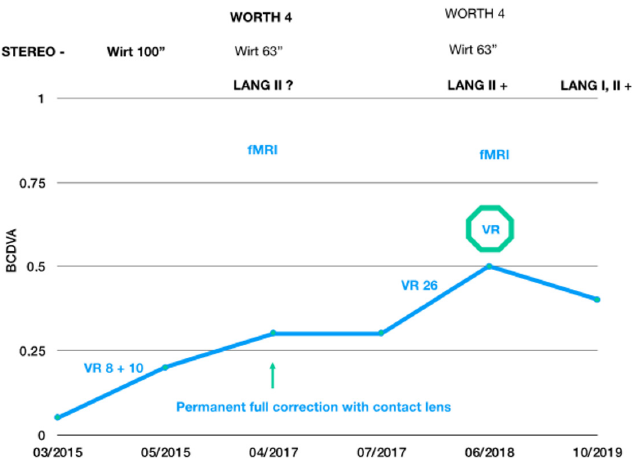
Figure 2. Summary of the visual training scheme. Time points are recorded on the x -axis, gains in BCDVA are recorded on the y -axis, and changes in stereopsis are recorded on top of the scheme. VR signs with different numbers denote how much time the patient spent in visual training in VR in the clinic. fMRI denotes when functional magnetic resonance imaging was performed, i.e., before and after VR